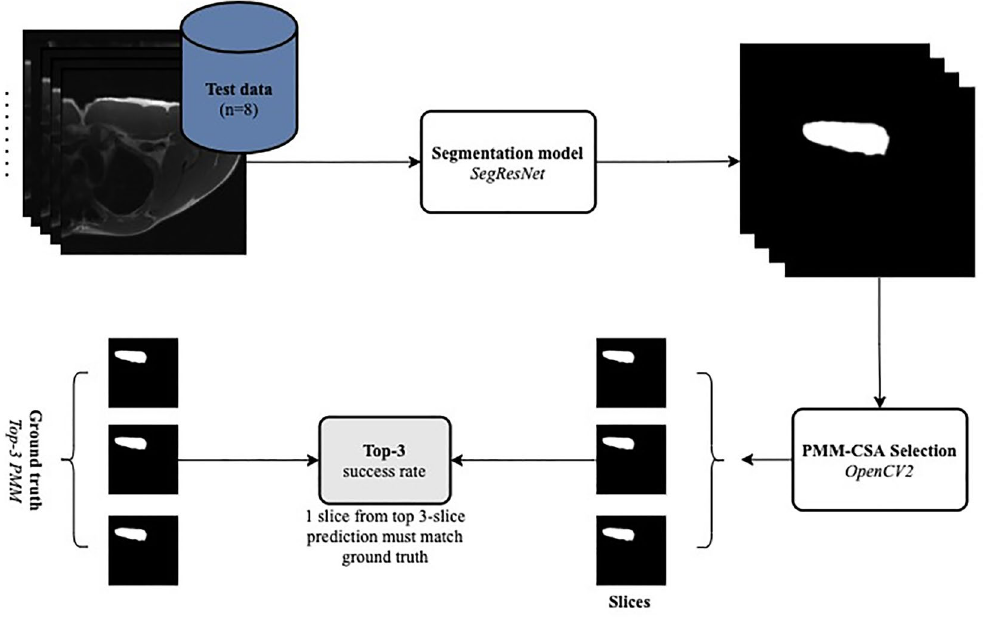
Figure 3. Workflow for PMM-CSA selection. The model predictions (segmentations) from the architecture trained were used for PMM-CSA selection, as well as the ground truth. The top-3 largest PMM-CSA slices were selected using OpenCV and compared with the ground truth.